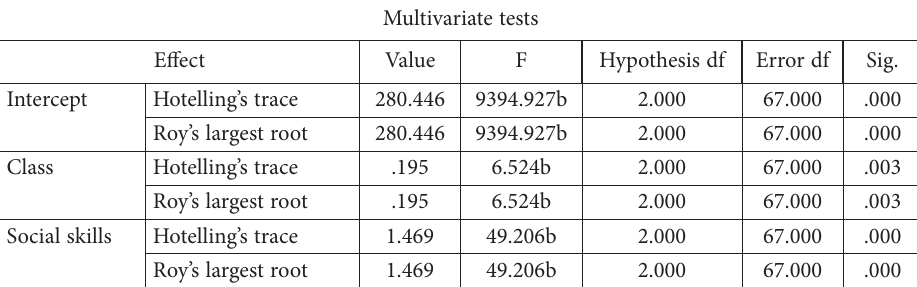
Table 1. The interaction of creative problem solving, creative processes and social skills (source: created by